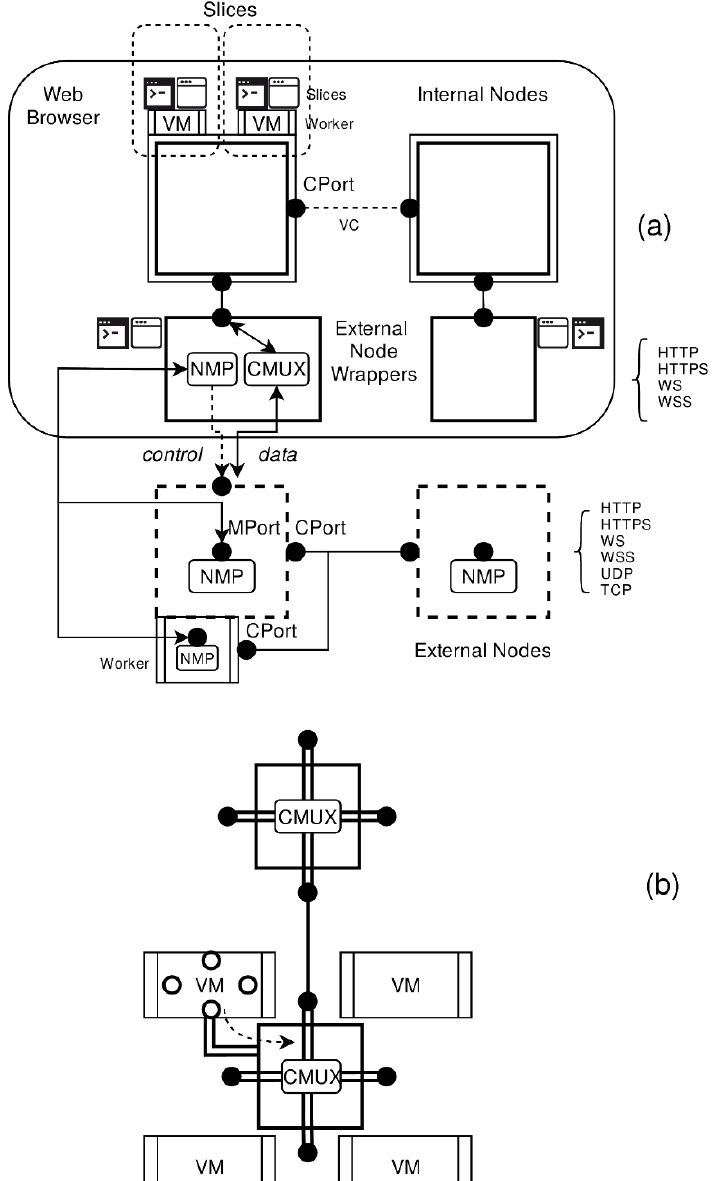
Figure 1. ( a ) General software framework and communication architecture with internal (double outline), external mapper (single outline), and external (dashed line) nodes. There are management communication ports (mPort) for connecting Web controllers with external nodes and generic communication ports (cPort) for inter-node communication ( b ) Message multiplexer architecture. Non-filled circles represent internal communication port, filled circles represent external communication port.